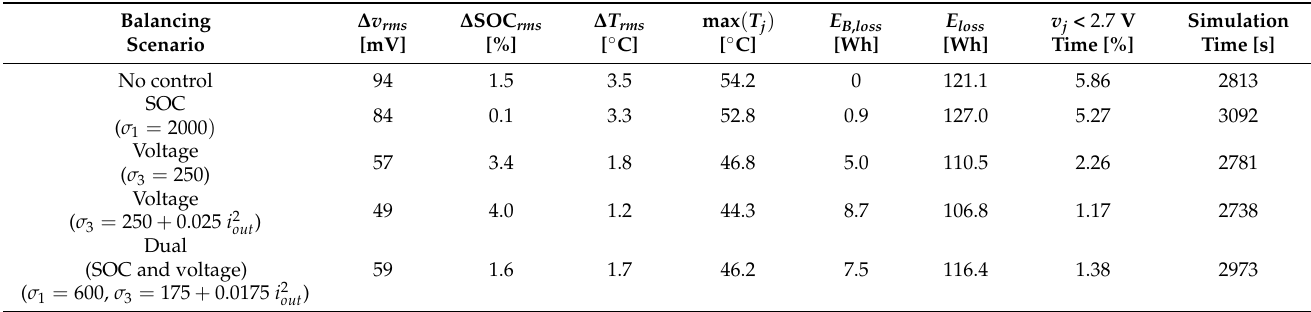
Table 4. Key metrics of single and dual controllers results shown in Figure